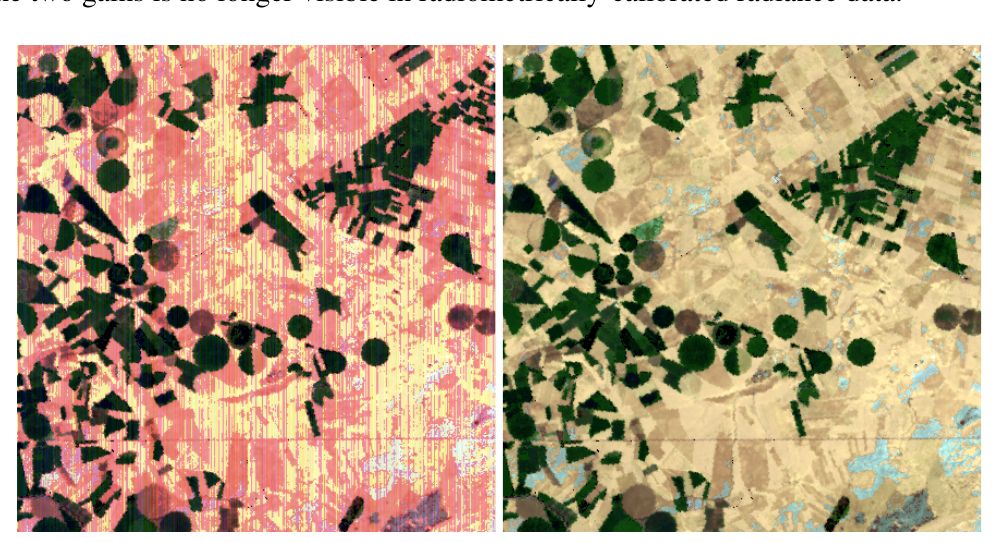
Figure 6. Red-green-blue composites from a simulated EnMAP dataset over Barrax (Spain) illustrating the conversion from digital numbers ( left ) to radiometrically-calibrated radiance data ( right ). The switch between high and low radiometric gain modes is visible in the digital number image as yellowish and pinkish